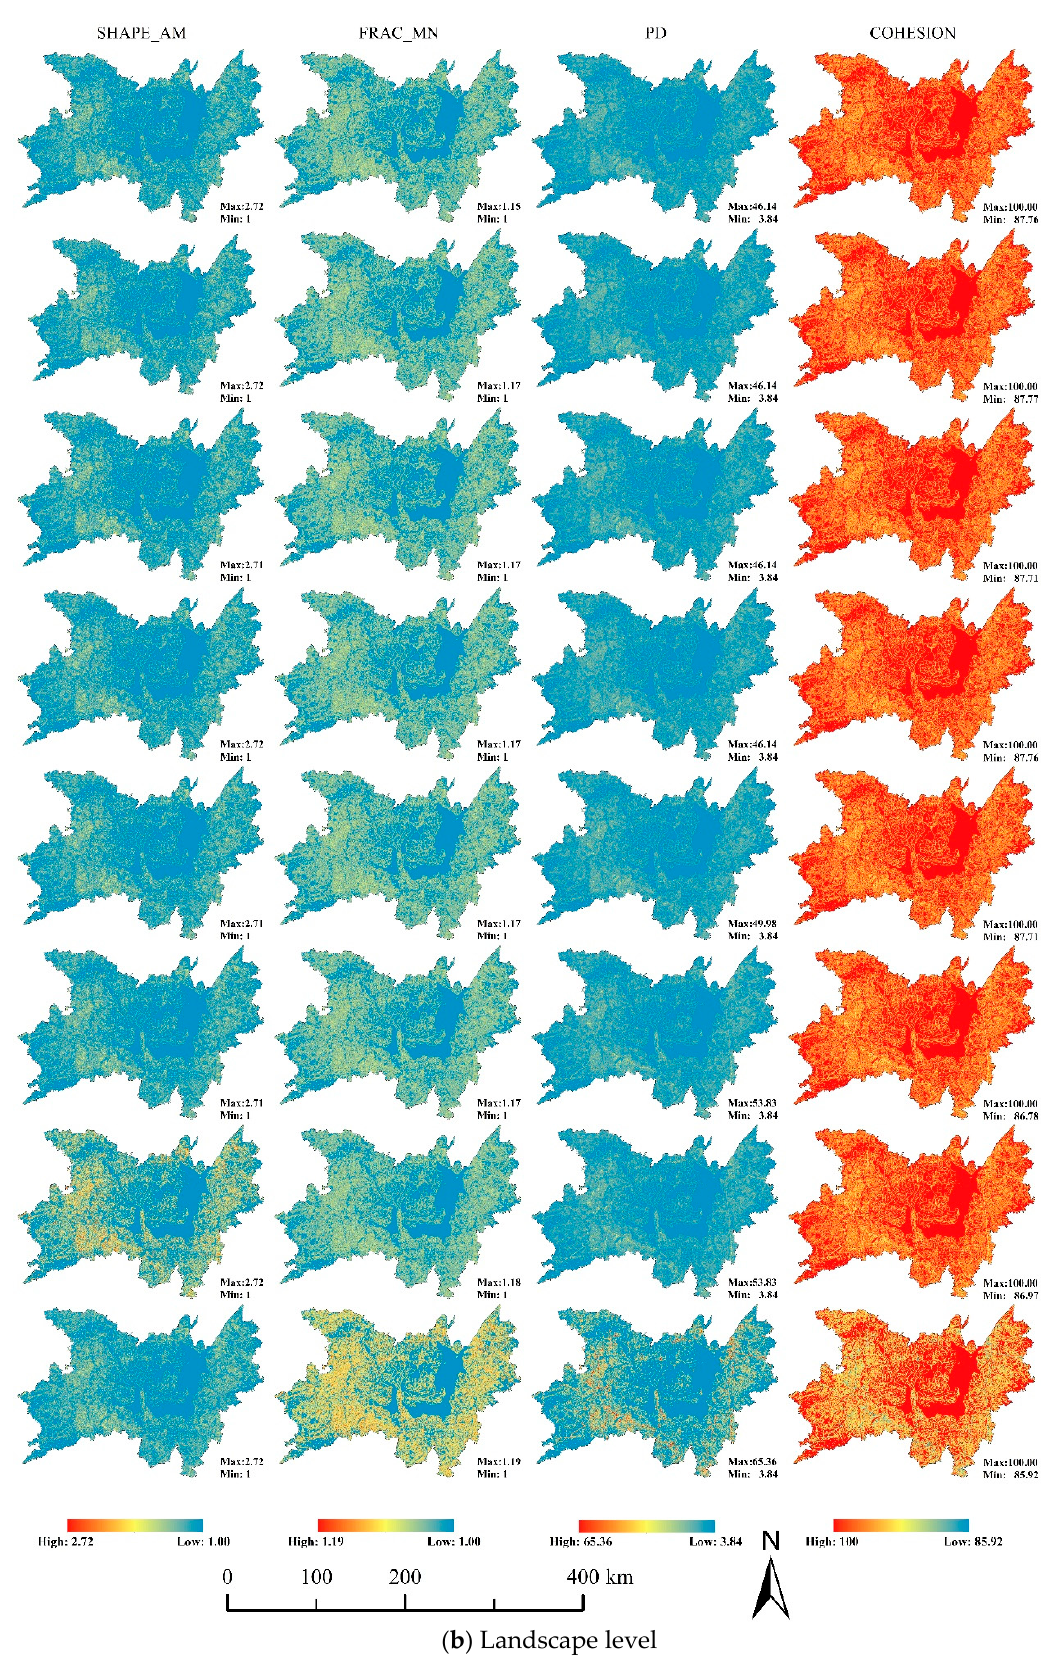
Figure 8. Change of landscape pattern indexes by moving window method. ( a ) Class-level landscape pattern indexes change; ( b ) Landscape-level landscape pattern indexes change.